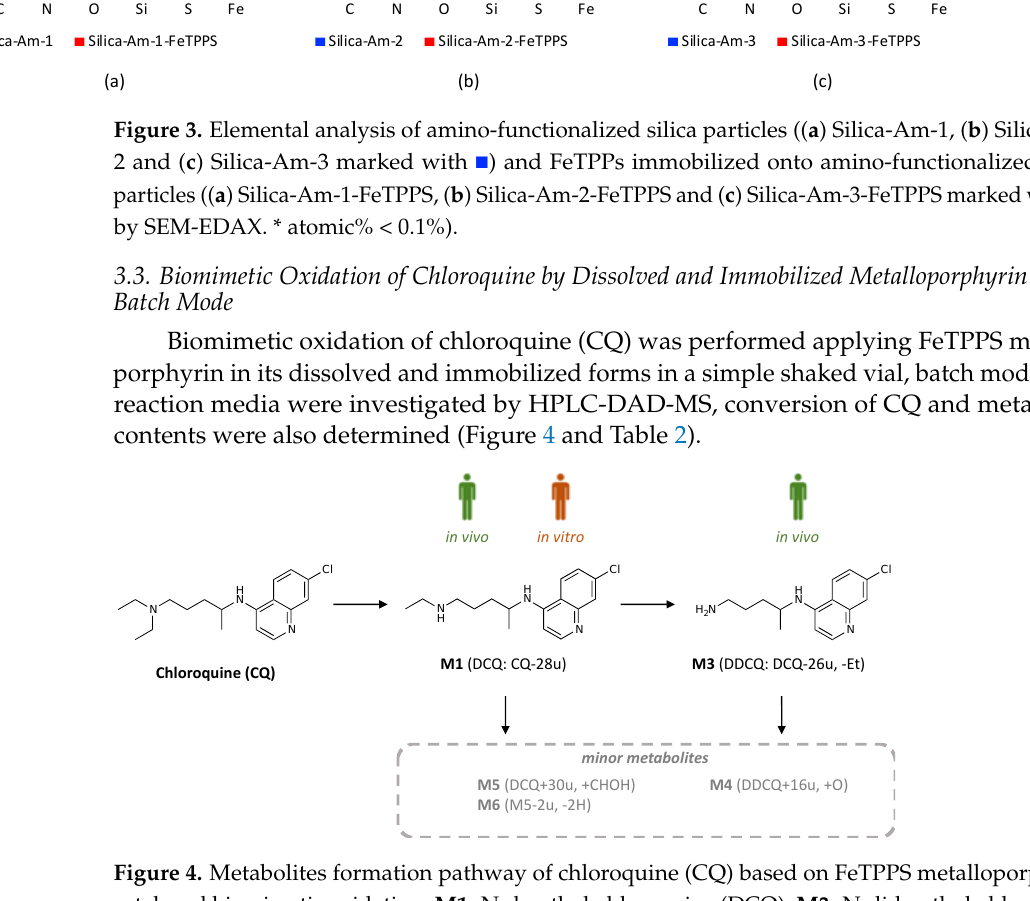
Figure 4. Metabolites formation pathway of chloroquine (CQ) based on FeTPPS metalloporphyrin catalyzed biomimetic oxidation. M1 : N-desethyl-chloroquine (DCQ), M3 : N-didesethyl-chloro- quine (DDCQ), and minor metabolites M4 , M5 : hydroxymethylated N-desethyl-chloroquine and M6 : N-formamide analogue of M5 .